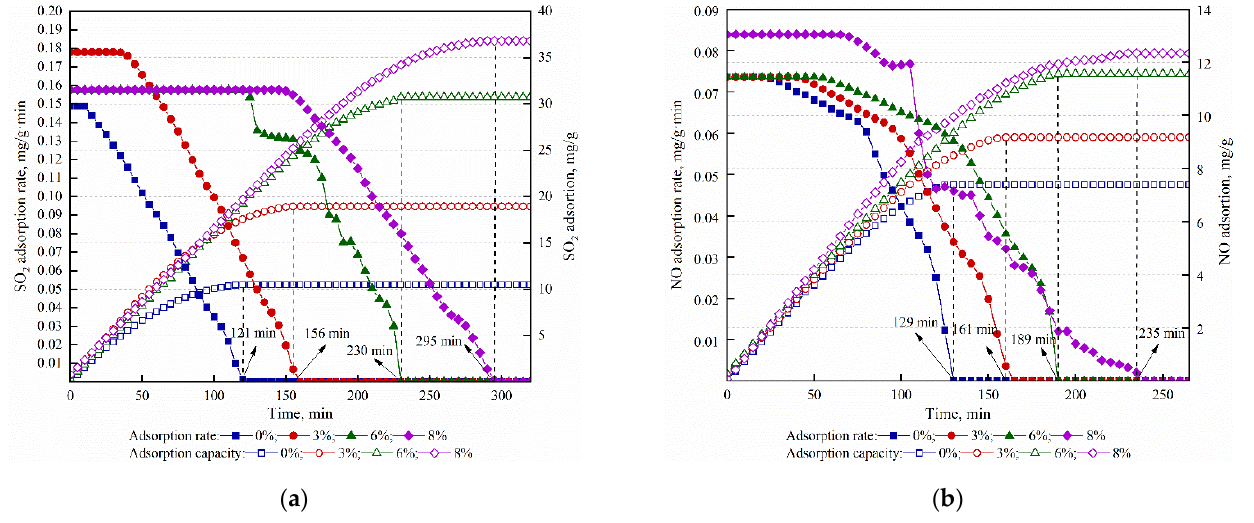
Figure 8. ( a ) The effect of O 2 concentration on SO 2 adsorption performance; ( b ) the effect of O 2 concentration on NO adsorption performance.